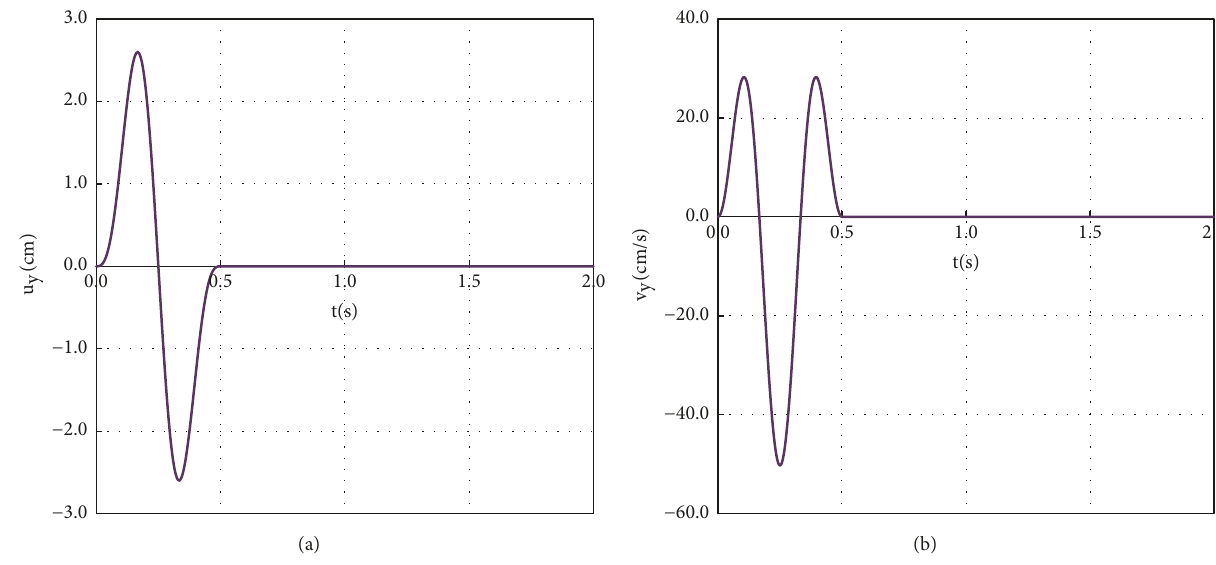
Figure 8: Time histories of vertical design ground motion: (a) displacement and (b)